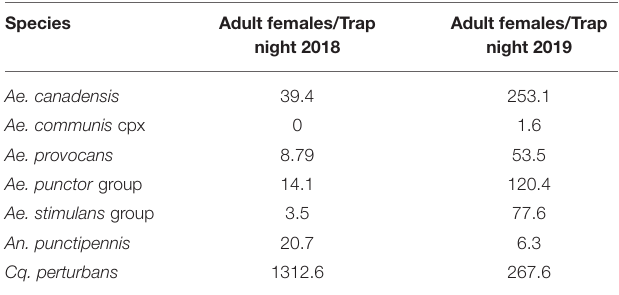
TABLE 3 | Adult female mosquitoes collected in carbon dioxide-baited light traps, normalized as trap night (total collected/total trap events).